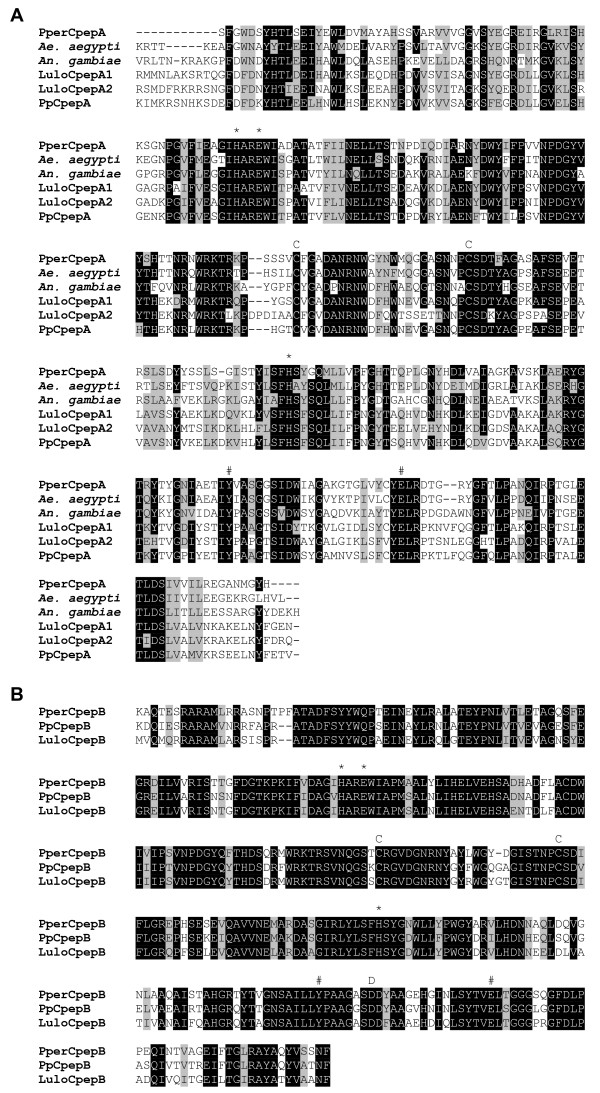
Sequence alignment of putative midgut carboxypeptidases. (A) Comparison of mature Carboxypeptidase A proteins of Aedes aegypti (A. aegypti), Anopheles gambiae (A. gambiae), Phlebotomus perniciosus (Pper), Phlebotomus papatasi (Pp) and Lutzomyia longipalpis (Lulo). N-terminal portion of the peptides are not shown due to PperCpepA 5' mRNA truncation. Conserved cysteines are indicated (C), metal binding residues are marked by (*) and catalytic residues are marked by (#). (B) Comparison of mature Carboxypeptidase B proteins of P. perniciosus (Pper), P. papatasi (Pp) and L. longipalpis (Lulo). Conserved cysteines are indicated (C), metal binding residues are marked by (*), catalytic residues are marked by (#) and a conserved aspartate in the binding pocket of carboxypeptidases B is indicated (D). Accession numbers: PperCpepA [GenBank:EZ966131], A. aegypti [GenBank:AAT36730], A. gambiae [GenBank:AAB96576], LuloCpepA1 [GenBank:ABV60310], LuloCpepA2 [GenBank:ABV60311], PpCpepA [GenBank:ABV44738], PperCpepB [GenBank:EZ966132], PpCpepB [GenBank:ABV44754], LuloCpepB [GenBank:ABV60312].